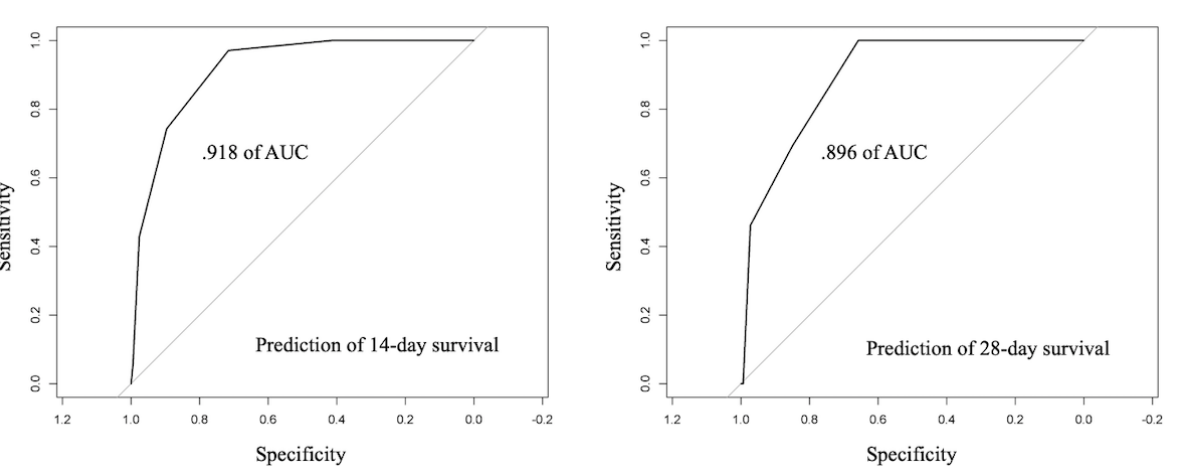
Figure 3. Receiver operating characteristics curve analysis of the newly developed COVID-19 prognosis score system in the validation cohort. A receiver operating characteristic curve analysis achieved an area under the curve value of (A) 0.918 (95% CI, 0.91-0.927) for 14-day survival and (B) 0.896 (95% CI 0.872-0.911) for 28-day